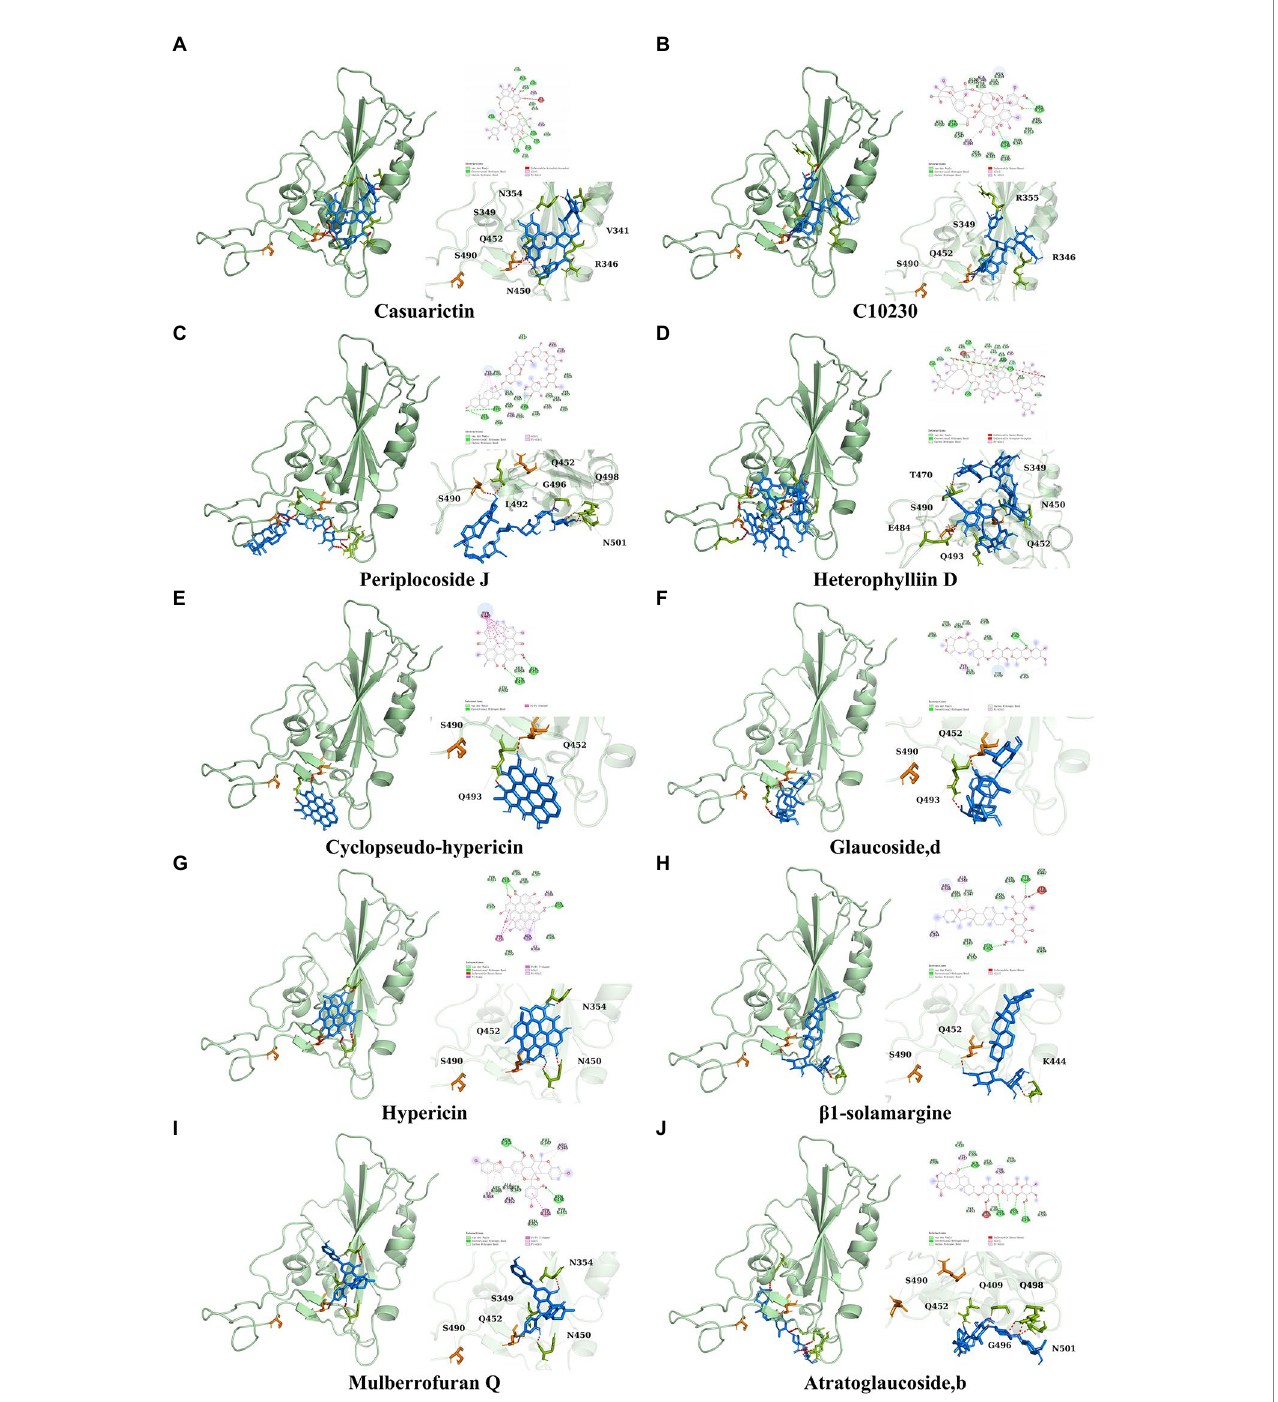
FIGURE 3 The top 10 conformations of the small molecule compounds bind to the Lambda strain mutation base. (A) Casuarictin. (B) C10230. (C) Periplocoside J. (D) Heterophylliin D. (E) Cyclopseudo-hypericin. (F) Glaucoside, d. (G) Hypericin. (H) β 1-solamargine. (I) Mulberrofuran Q. (J) Atratoglaucoside, b.